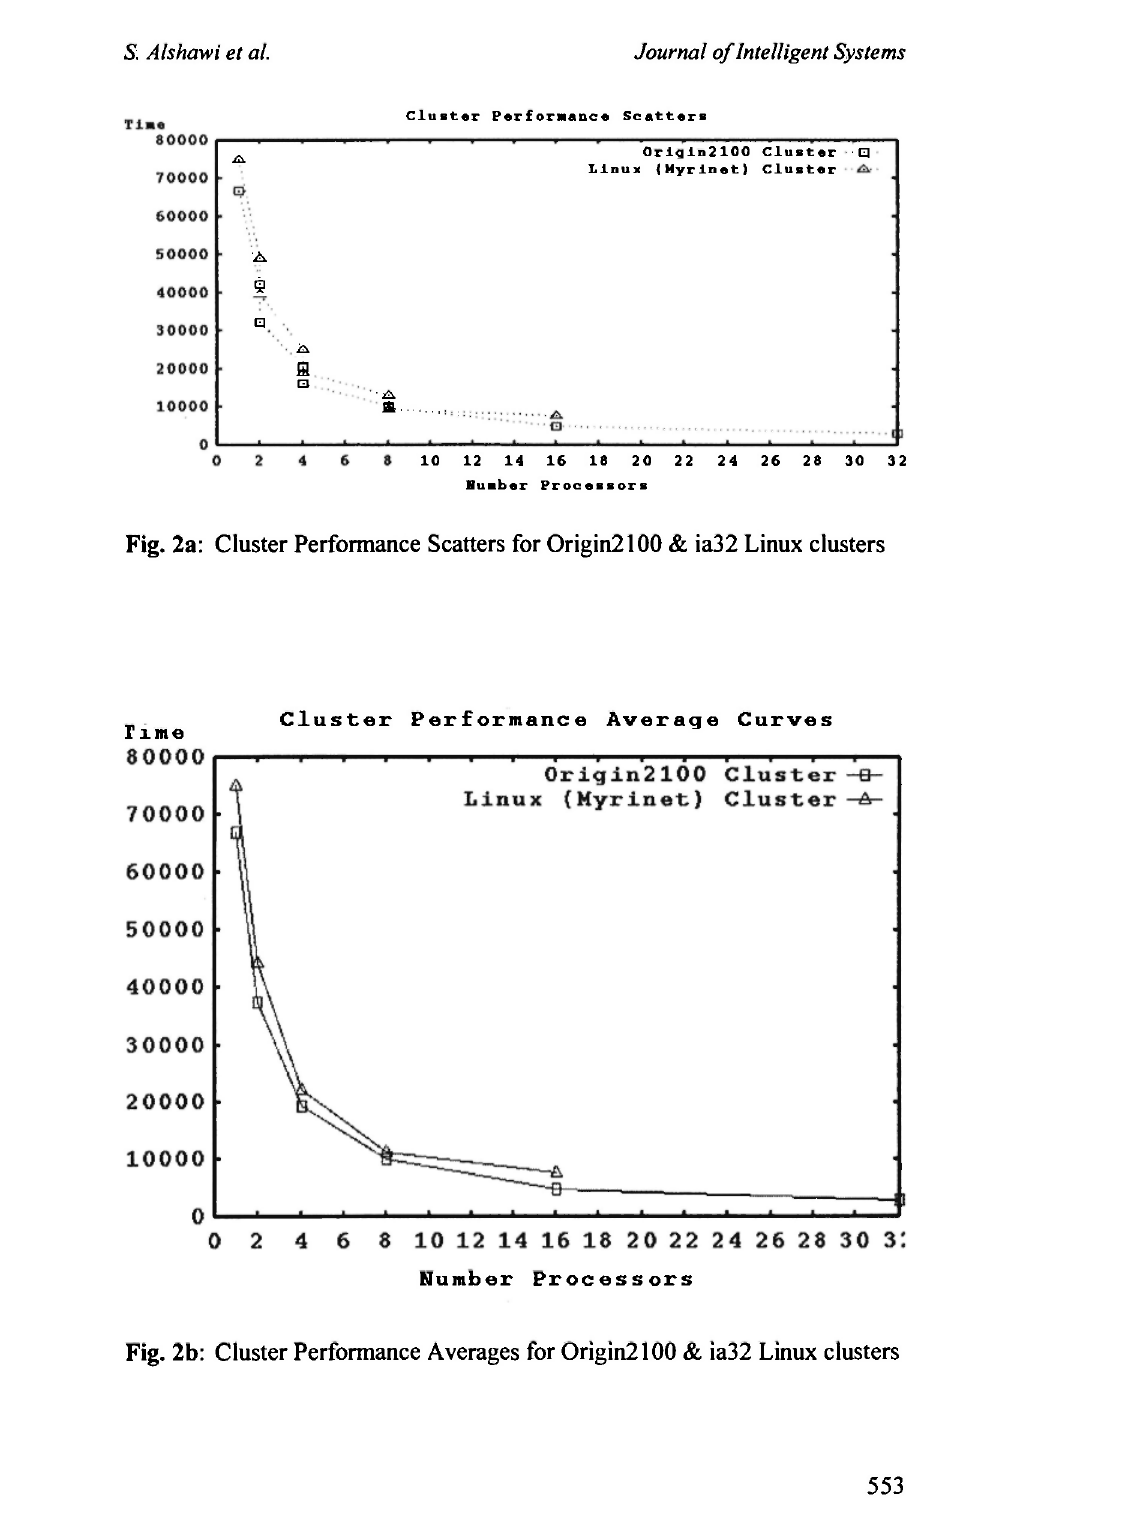
Fig. 2b: Cluster Performance Averages for 0rigin2100 & ia32 Linux